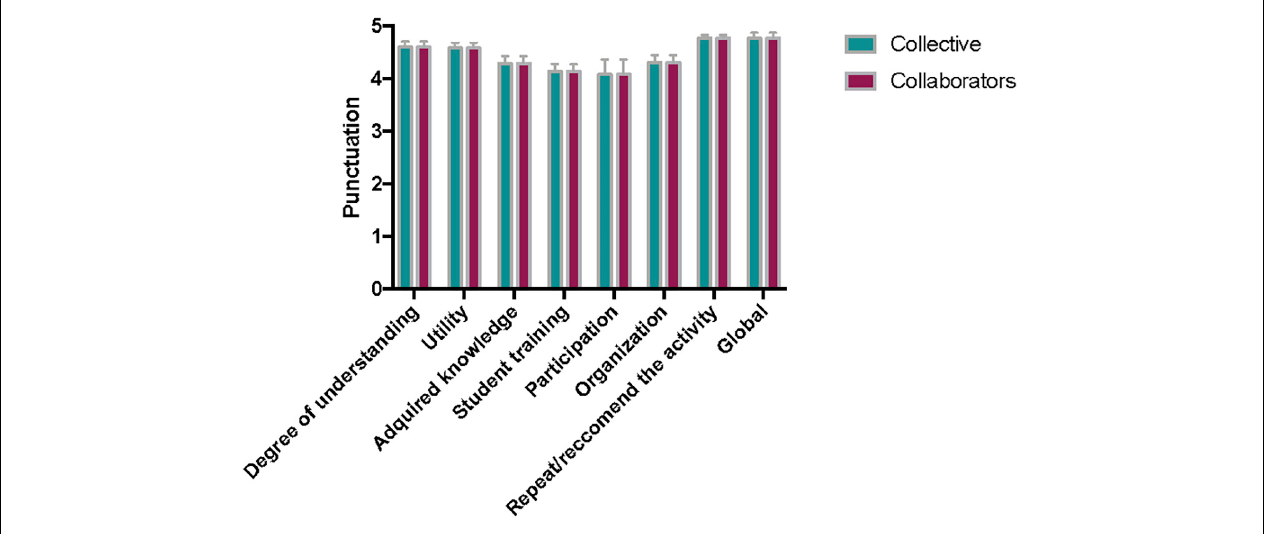
FIGURE 3 | Selected survey results from community partners (collective, n = 54; collaborators, n = 7) involved in Movies and Infectious diseases S-L project at Universidad Complutense de Madrid, Spain. All data are expressed as mean and standard deviation on a 1–5 scale (1, very low/strongly disagree; 5, very high/strongly